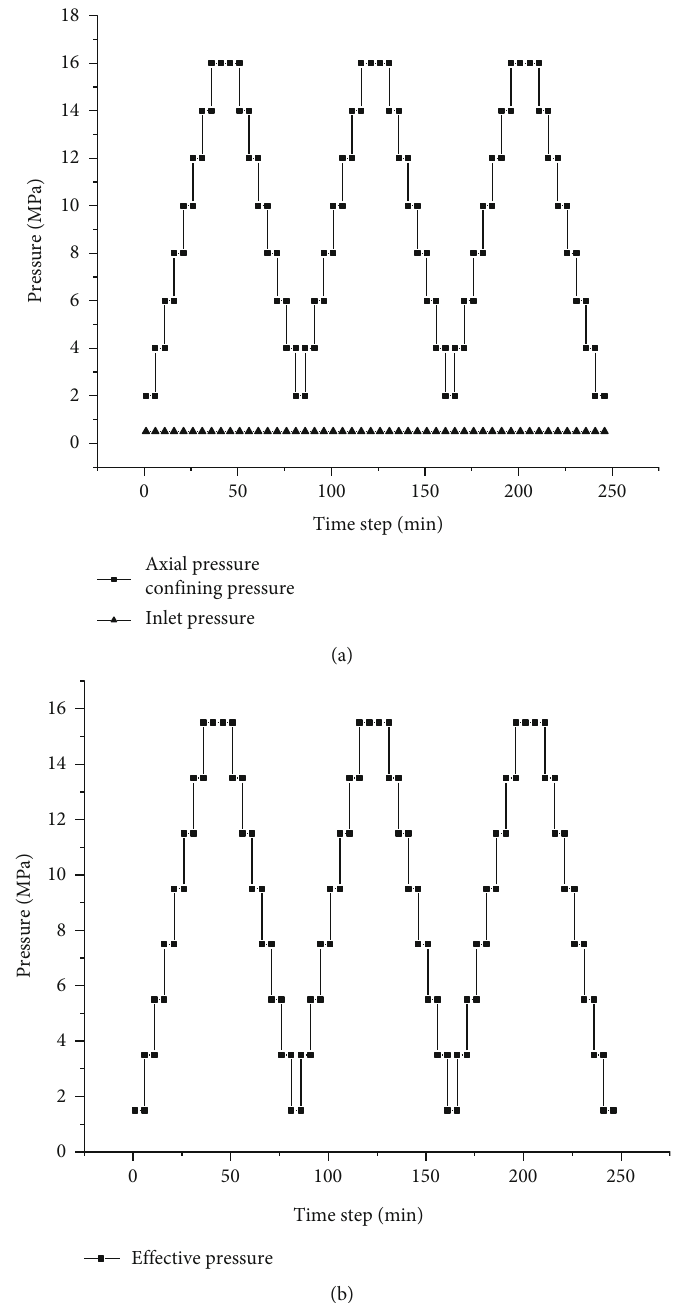
Figure 2: (a) Stress path and (b) e ff ective stress